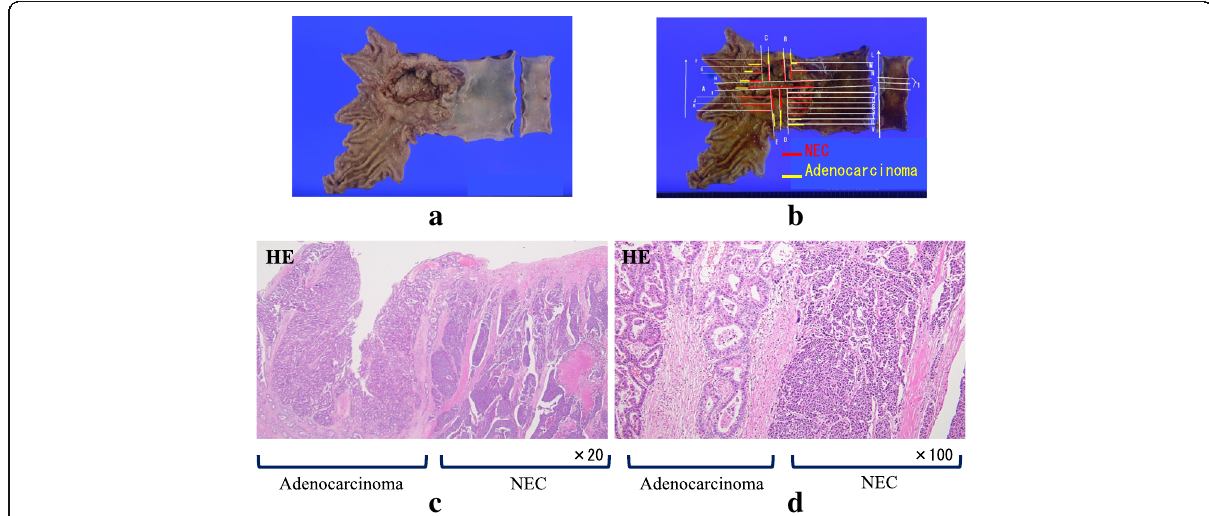
Fig. 6 Surgical specimen and histopathological examination. a , b Surgical specimen of the esophagogastric junction. An ulcerated mass measuring 10.0×7.5 cm in size was seen. c , d Histopathological examination of the resected specimen revealed two distinct components, an adenocarcinoma component and a NEC component, with no zone of transition between the two components